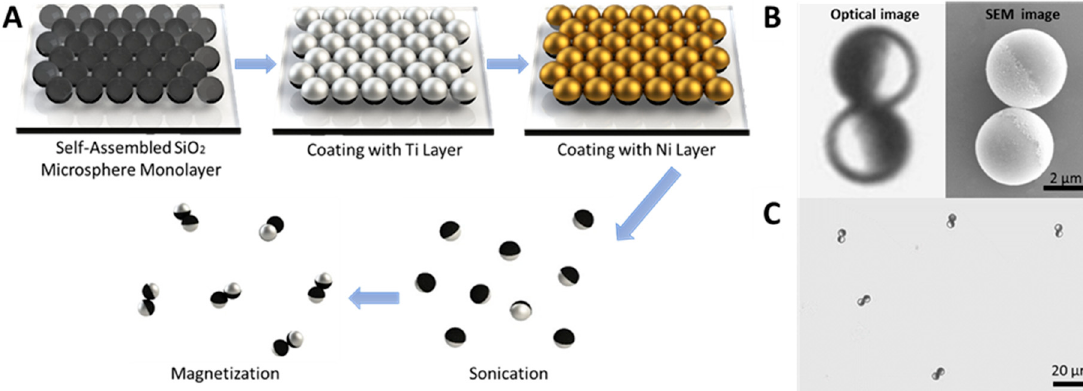
Figure 4. ( A ) Schematic illustration of the electron beam evaporation process. ( B ) Magnified optical microscopy image and the corresponding SEM image of a microdimer, highlighting its staggered shape and the magnetic hemispheres (dark under the optical microscope, bright under the SEM). ( C ) Optical microscopy image of a few representative microdimers after magnetization. Adapted with permission from Reference [85], copyright Advanced Functional Materials 2018.